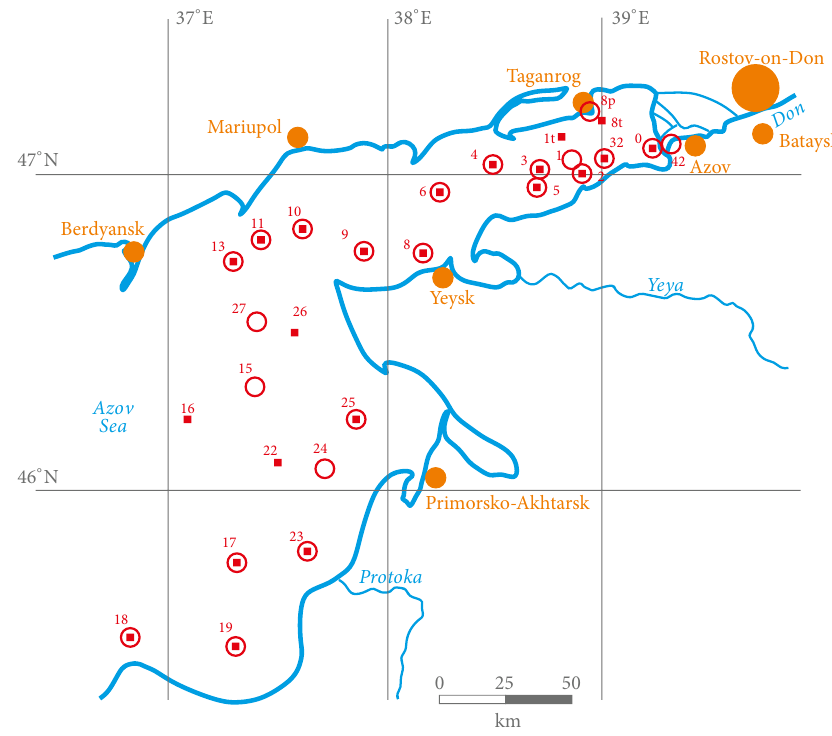
Figure 1: Location of sampling stations.